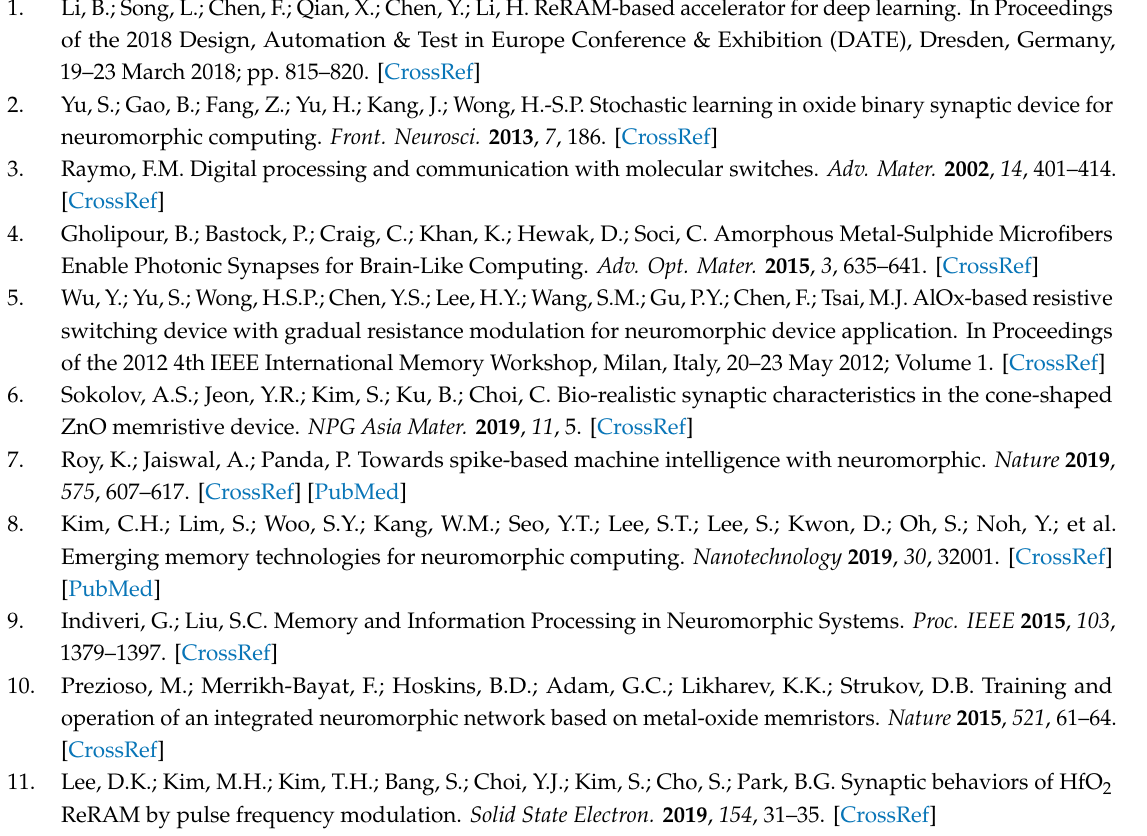
Figure S1: Statistical distribution (cycle-to-cycle) of TiN / Ti / TiO2 / SiOx / Si device in the HRS and LRS, Figure S2: Potentiation and depression curves of TiN / Ti / TiO2 / SiOx / Si device depending on the pulse width. Potentiation: (a) 100 µ s, (b) 1 ms, (c) 10 ms, (d) 100 ms. Depression: (e) 100 µ s, (f) 1 ms, (g) 10 ms, (h) 100